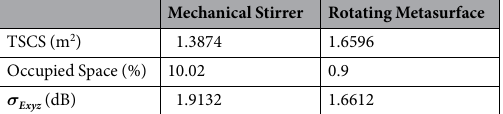
Table 1. Comparisons between the RC with mechanical stirrer and RC with rotating metasurface, including TSCS, ratio of the occupied space (volume of stirrer and metasurface over the total volume of the RC), and average standard deviation of the field strengths for the combination of xyz